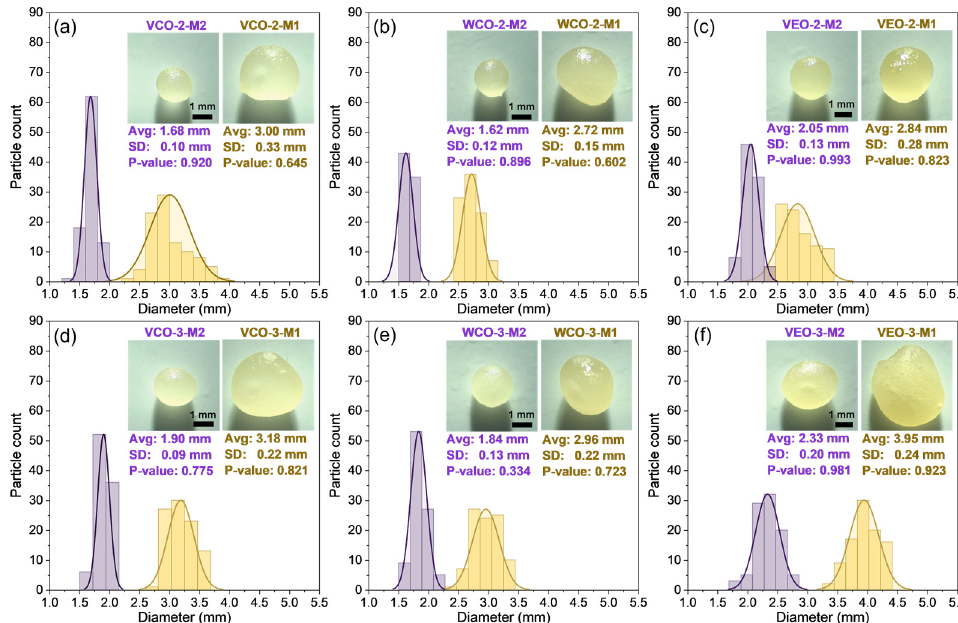
Figure 3. Statistical distribution of the size of each type of capsule fitted to a normal distribution: ( a ) VCO-2-M1 and M2; ( b ) WCO-2-M1 and M2; ( c ) VEO-2-M1 and M2; ( d ) VCO-3-M1 and M2; ( e ) WCO-3-M1 and M2; ( f ) VEO-3-M1 and M2.